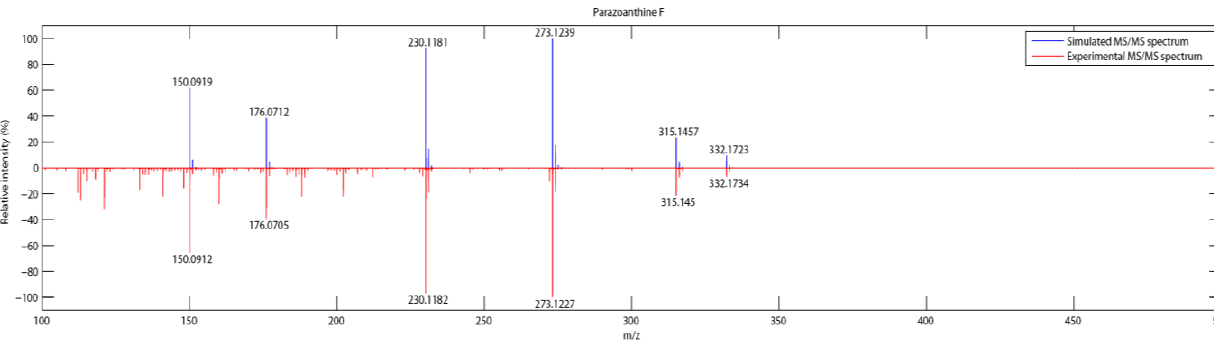
Figure 4. Comparison between simulated and experimental MS/MS spectra.